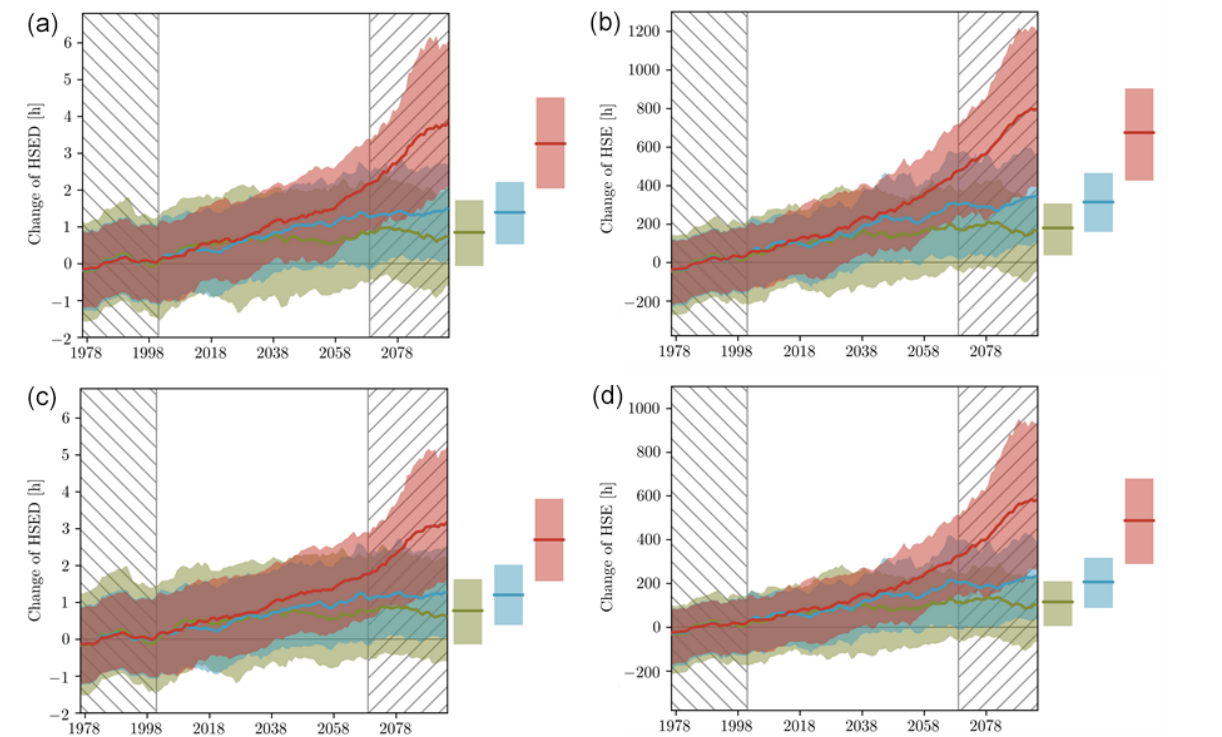
Figure 6. Projected change in heat stress events in the reference barn in central Europe without (a, b) and with (c, d) consideration of near-surface wind. Modifications in annual average of duration (average consecutive hours) and number (number of consecutive hours) of at least moderate stress events under RCP 2.6 (green), RCP 4.5 (blue) and RCP 8.5 (red) are plotted based on the equivalent temperature index for cattle (ETIC) with a threshold of